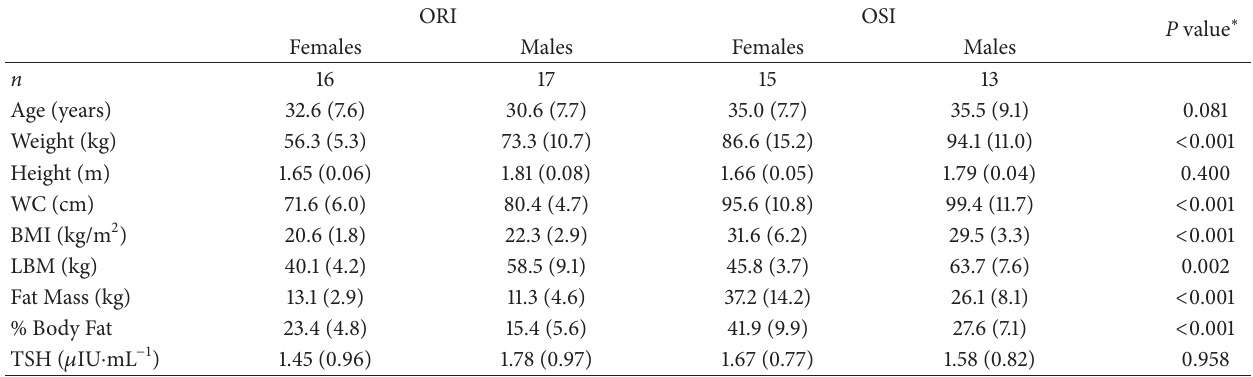
Table 1: Characteristics of obesity resistant individuals (ORI) and obesity susceptible individuals (OSI).